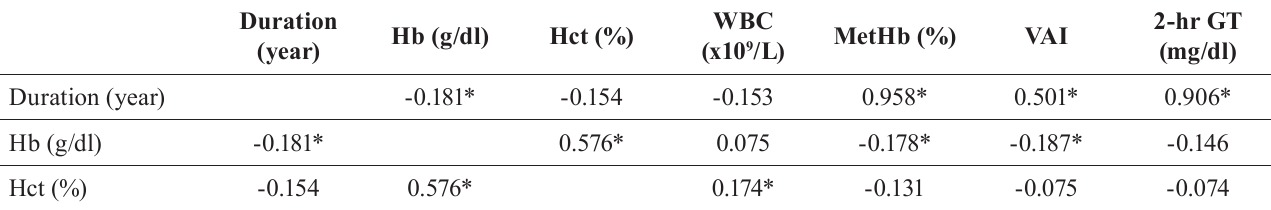
TABLE II - Correlation ( r values) between the duration of cigarette smoking and some of the studied markers in